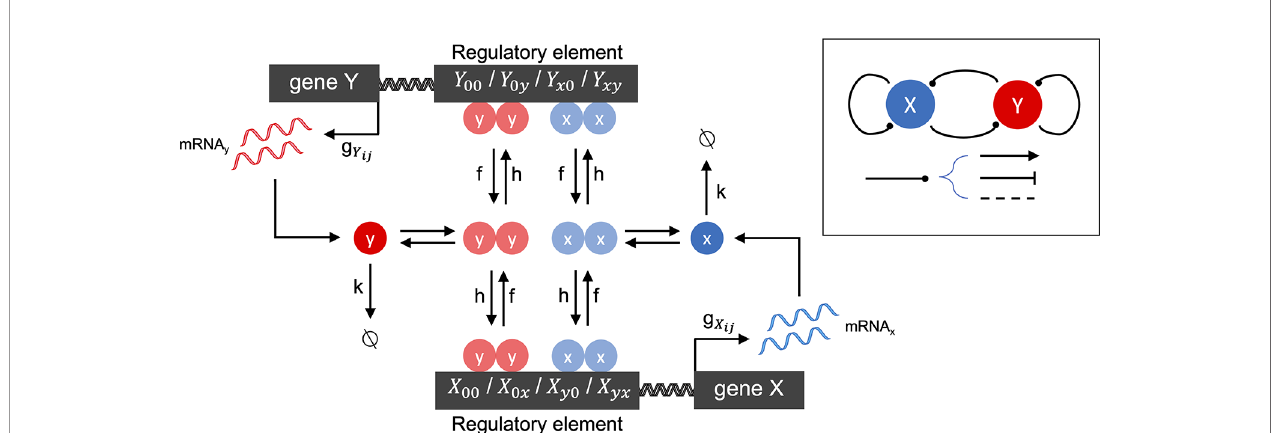
FIGURE 1 | Schematic of the two-gene regulatory network model. The overall network motif is variable (see Inset), encoding a symmetric combination of repression ( fl at arrow-head), activation (pointed arrow-head) or no-impact (dashed line), mutually between the two genes labeled X and Y , and by each gene on itself (see Methods for details). The stochastic reaction kinetic model includes rate constants for mRNA synthesis ( gij ), mRNA degradation ( k ), and regulatory element state- changes due to transcription factor binding ( h ) and unbinding ( f ). Cooperative effects are included by the assumption that transcription factors bind as